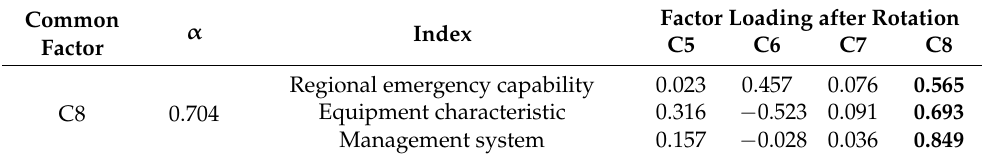
Table 3. Load matrix after